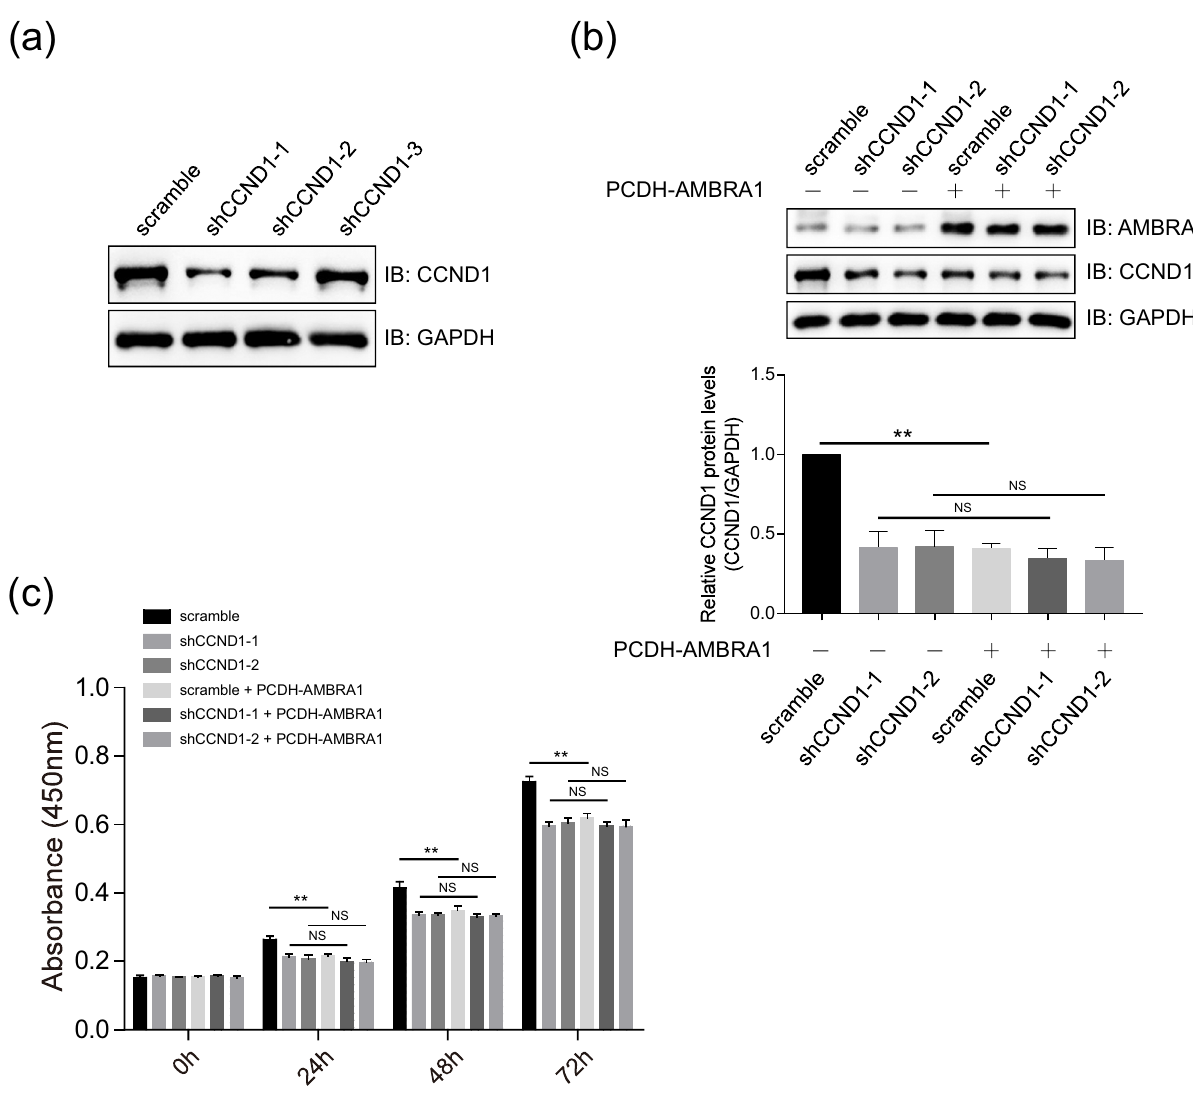
Figure 6: AMBRA1 regulates the proliferation of UVM cells in a CCND1 - dependent manner. ( a ) Test of the knockdown e ffi ciency of shRNAs targeting CCND1 by immunoblotting analysis. The shRNAs for CCND1 were transfected into 92.1 cells, and then hygromycin B ( 100 µg/mL ) selection was used to establish stably expressing cell lines before subjecting to immunoblotting analysis. ( b ) Detection of the protein levels of AMBRA1 and CCND1 in stable expression cell lines. The 92.1 cells stably expressing CCND1 were transfected with an empty vector PCDH or PCDH - AMBRA1, selected by hygromycin B selection ( 20 µg/mL ) and puromycin ( 5 µg/mL ) , and then subjected to immunoblotting analysis. The bands of CCND1 were quanti fi ed and compared to that of GAPDH. The data are expressed as mean ± SD and were analyzed using one - way ANOVA with Tukey ’ s post hoc test. NS, no signi fi cantly di ff erent; ** P < 0.01, very signi fi cantly di ff erent, the experiment was repeated thrice. ( c ) AMBRA1 inhibited the proliferation of 92.1 cells in a CCND1 - dependent manner. The 92.1 cells stably expressing shRNAs of CCND, and PCDH or PCDH - AMBRA1, were seeded into 96 - well plates. The cell viability was detected using the CCK - 8 assay at the indicated time points. The data were expressed as mean ± SD and were analyzed using one - way ANOVA with Tukey ’ s post hoc test. NS, no signi fi cantly di ff erent; **P < 0.01, very signi fi cantly di ff erent, and the experiment was repeated